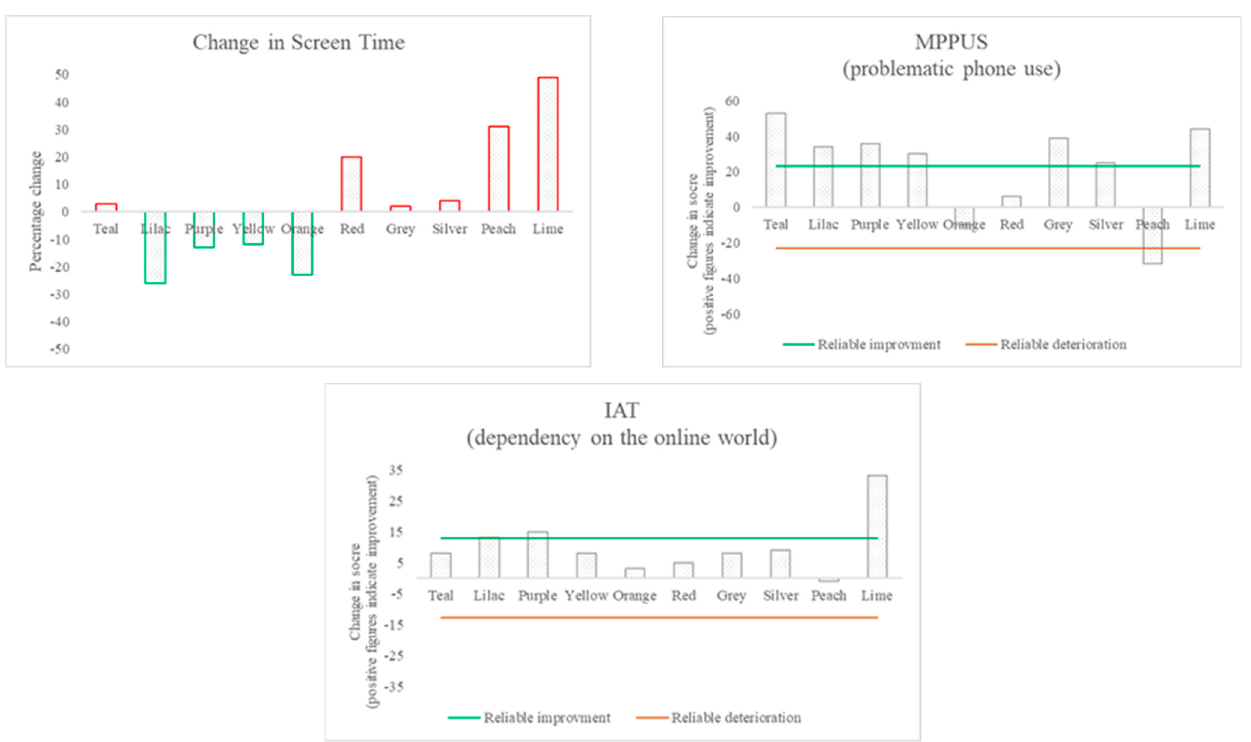
Figure 2. Changes in technology use: the difference between pre- and post-measurement for each participant.